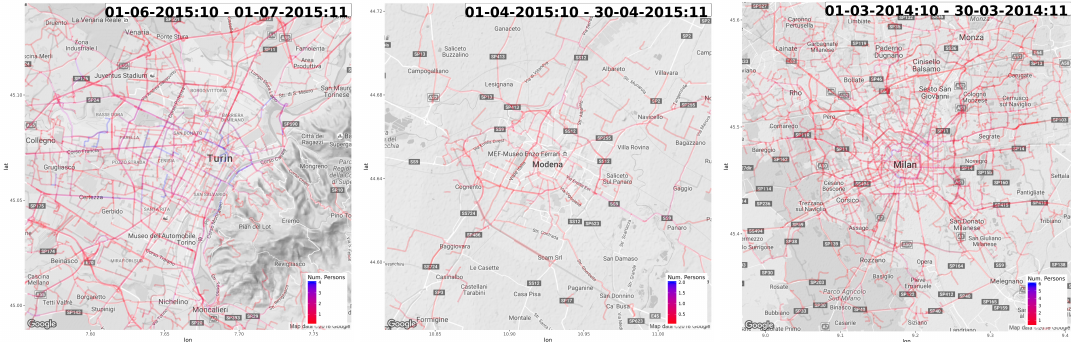
Figure 10. OD matrices from home-work commute mapped to the road network. Blue represent high flows, red low flows). ( left ) Torino. ( center ) Modena. ( right ) Milano.